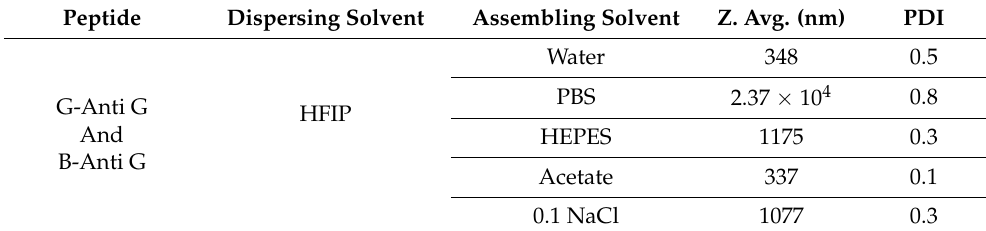
Table 2. Table showing size and PDI of PNPs determined in various solvent-buffers (1:19 v / v ) mixture. Peptide Dispersing Solvent Assembling Solvent Z. Avg. (nm) PDI Water 348 0.5 PBS 2.37 × 10 4 0.8 G-Anti G HFIP And HEPES 1175 0.3 B-Anti G Acetate 337 0.1 0.1 NaCl 1077